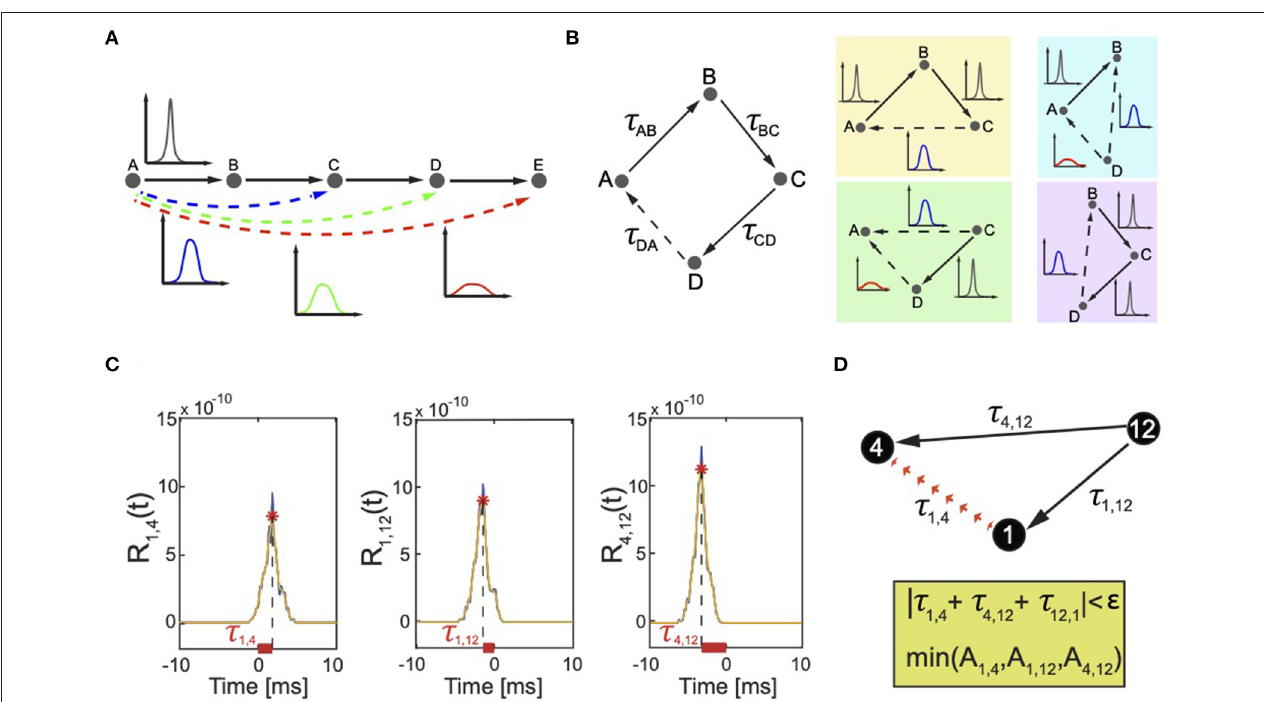
FIGURE 3 | Correlation peaks and correlation triangles. (A) The effect of indirect connectivity on correlation peaks. The edge AB, BC, CD, and DE are directed. The associated correlation peaks are high and narrow because there is a direct dependency between the activity of neuron A (B,C,D or E) and the one of neuron B (C,D or E). The links AC, AD, and AE are indirect, with increasing order of correlation between the neurons because of more intermediary cells on the paths that link A to C, D, and E. The longer the path, the weaker the dependency between the neurons that results in a lower and wider correlation peak. (B) Correlation triangles reconstruct all possible dependencies between neurons. On the left, a graph composed of four neurons A, B, C, and D (polygon ABCD). Each edge is associated with a correlation peak and corresponding correlation delay τ AB , τ BC , τ CD , and τ DA . True connections are indicated by solid lines. The delay τ DA corresponds to an indirect connection, which the algorithm must identify and discard. This is indicated by a dotted line. The edges AB and AC are apparent edges that are always present when signals are correlated and Equation (7) is satisfied. Therefore, the polygon ABCD can be decomposed in four triangles ABC, ACD, ABD, and BCD (each color represents a different triplet). The participating correlation triangles reconstruct all possible dependencies among all neurons in the polygon ABCD. Each correlation link is associated with a correlation peak whose amplitude and width depends on the length of the indirect correlation path connecting the two correlated neurons (see Figure 3A ). In triangles ACD and ABD, the delay τ DA results from a signal that has propagated through three links AB, BC, and CD. Thus, τ DA will be detected and discarded because having lower amplitude and wider peak than the other peaks. (C) Real case scenario of correlation triangles and detection of FP connections. Correlation functions R 1,4 , R 1,12 , R 4,12 computed for pairs of biological neurons (1,4), (1,12), (4,12) (blue line) connected as in panel (B). The selected time window was (-20 ms, +20 ms), but the graph only shows a zoomed view in ( − 10 ms, +10 ms) to better describe the selection rule if only one correlation was detected in time between the neurons. The σ of the Gaussian filter was 0.0005s, resulting in smoothed correlation signals (orange dashed line). The detected correlation peaks (red stars) represent functional correlations between neurons and their combinations define the correlation triangles that our algorithm uses to detect FP connections. The horizontal offset between the position of each peak and the origin represents the temporal delay τ j , k associated with these links. (D) These delays satisfy the cyclic condition on τ , i.e., | τ 1,4 + τ 4,12 + τ 12,1 | = | τ 1,4 + τ 4,12 − τ 1,12 | < 3 ms, therefore indicating that one of the three correlations in the correlation triangle corresponds to an apparent link. The algorithm detects which of the three by searching for the correlation peak with smallest amplitude. In the example, A 1,4 has the smallest amplitude and the algorithm discards it from the analysis preventing generation of an FP